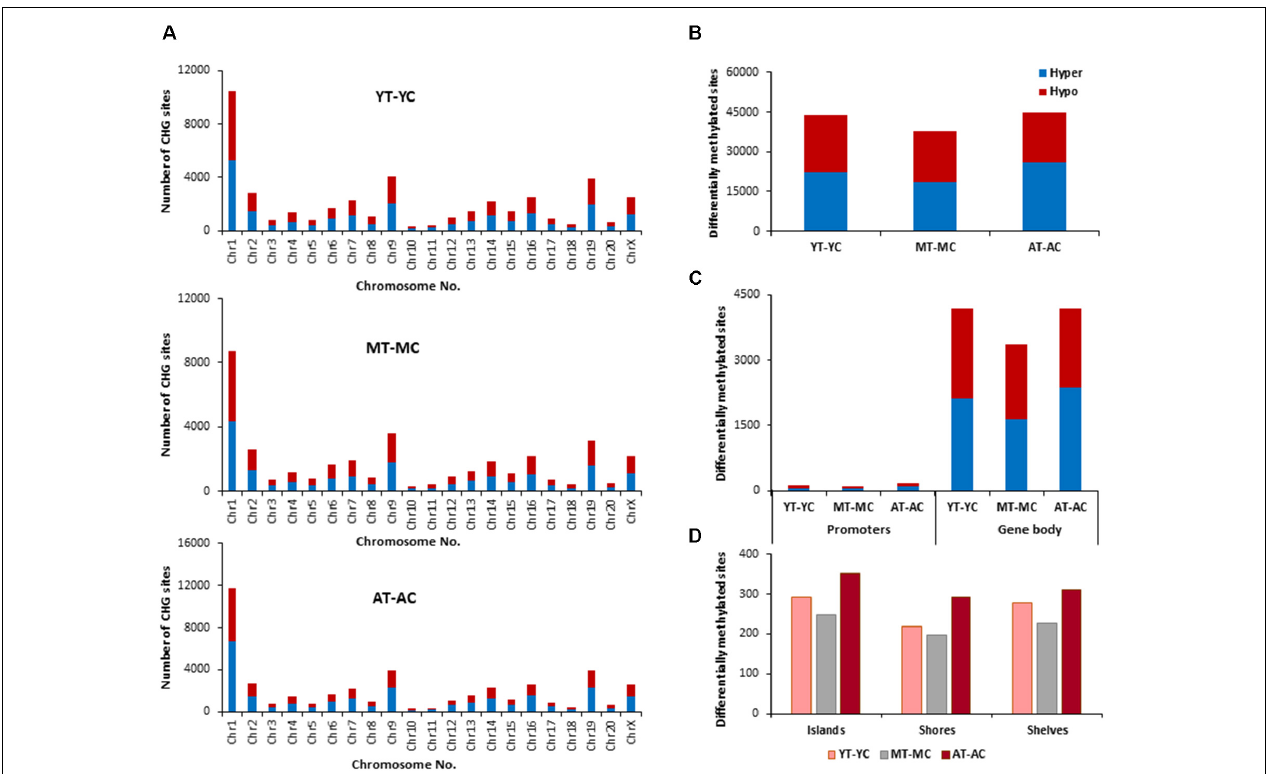
FIGURE 5 | Age-related differences in DNA CHG methylation due to E2-treatment. (A) Differentially methylated CHG sites along the chromosome (1–20) including X-chromosome for each age. The differential methylation was based on a statistical significance of p < 0.01. (B) Total number of differentially methylated CHG sites induced by E2-treatment for each age group. The red bars denote hypomethylation and blue bar denotes hypermethylation for the E2-treatment group relative to the age-matched control group. (C) Number of differentially methylated CHG sites in promoter and gene body regions in E2-treated relative to age-matched controls. (D) Comparison of the differentially methylated CHG sites across the regulatory regions: islands, shores, and